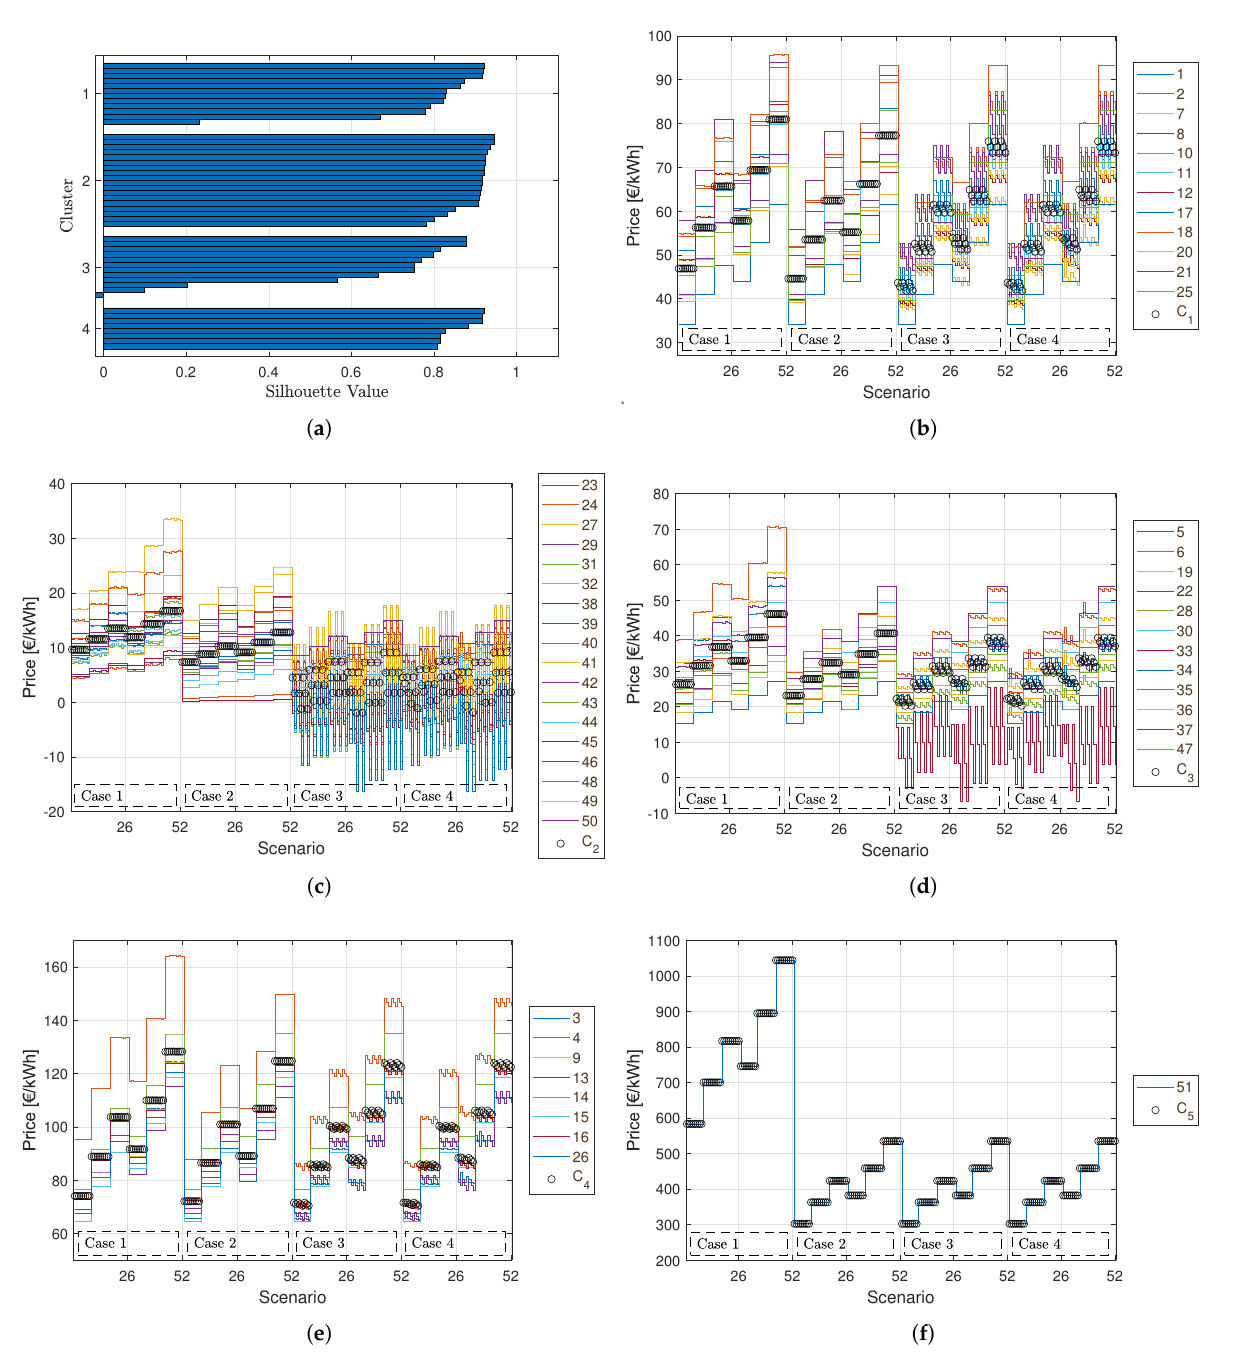
Figure 12. Clusters. ( a ) Silhouette from the clustered data. ( b ) Cluster 1. ( c ) Cluster 2. ( d ) Cluster 3. ( e ) Cluster 4. ( f ) Cluster 5. Not considered in the clustering method. Therefore, the cluster with the majority of the users and higher diversity is Cluster 2; in fact, it is the most attractive one for users due to their payment remunerations. However, it is important to highlight that these users usually have low inflexible power demand or high PV